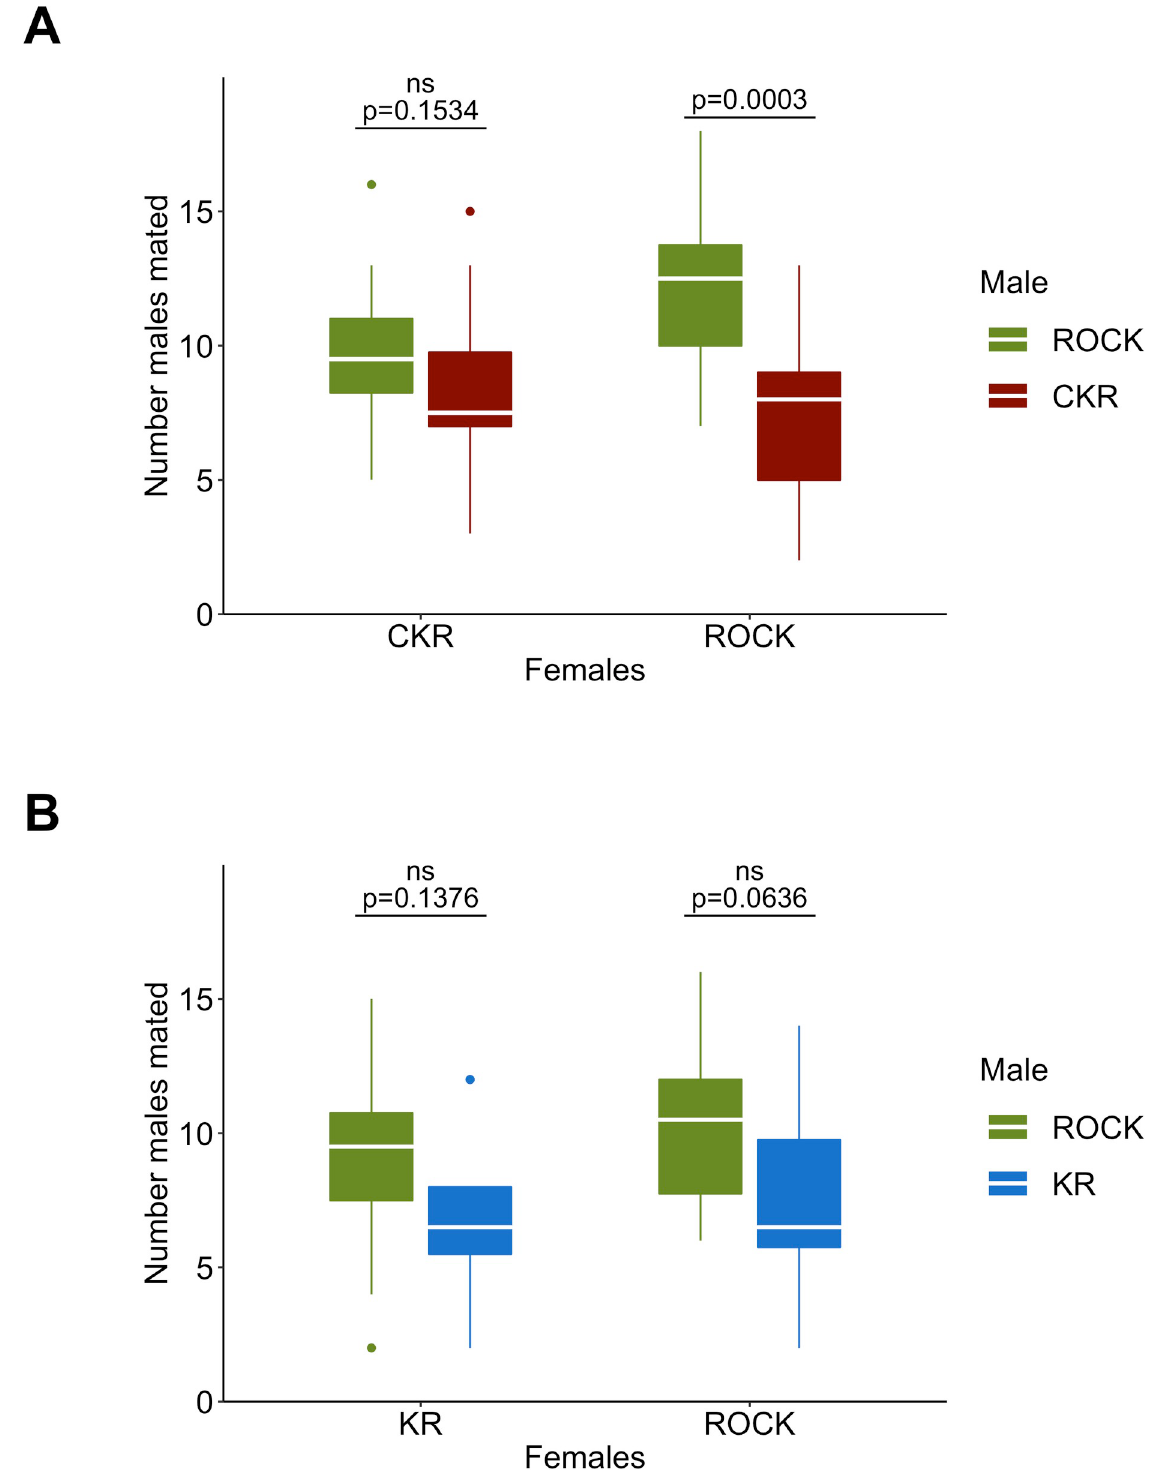
Fig 4. Mating competition comparison between ROCK and either CKR (A) or KR (B) strains of A . aegypti . Box plot of the number of males that mated with either ROCK or a resistant (CKR or KR) females. The white line in the middle represents the median, the lower and upper hinges correspond to the first and third quartiles (the 25th and 75th percentiles), the whiskers represent the minimum and maximum values no further than 1.5 times the distance between the first and third quartiles, and the points are the outliers (data beyond the end of the whiskers). ns = not statistically